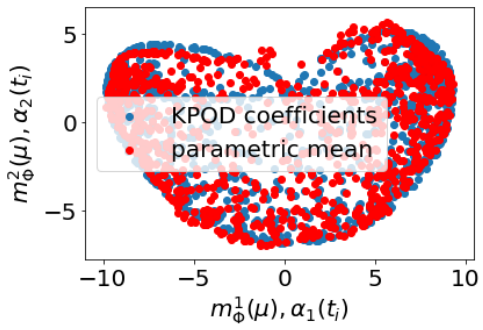
Figure 15. (Data-targeted VAE) log ( ∑ M epoch number on the abscissa axis.